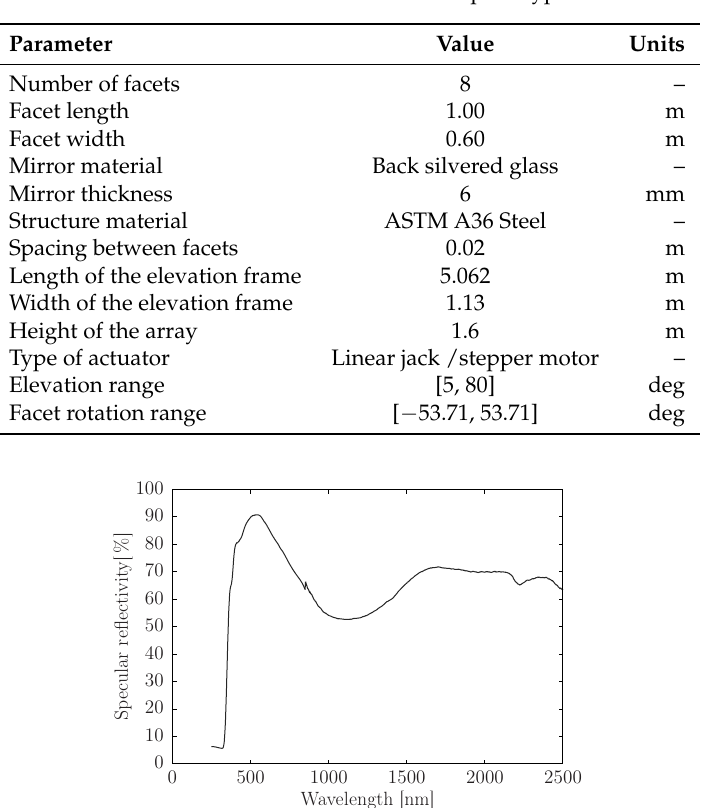
Figure 13. Structure of the mini-heliostat array prototype. Table 1. Main characteristics of the prototype.